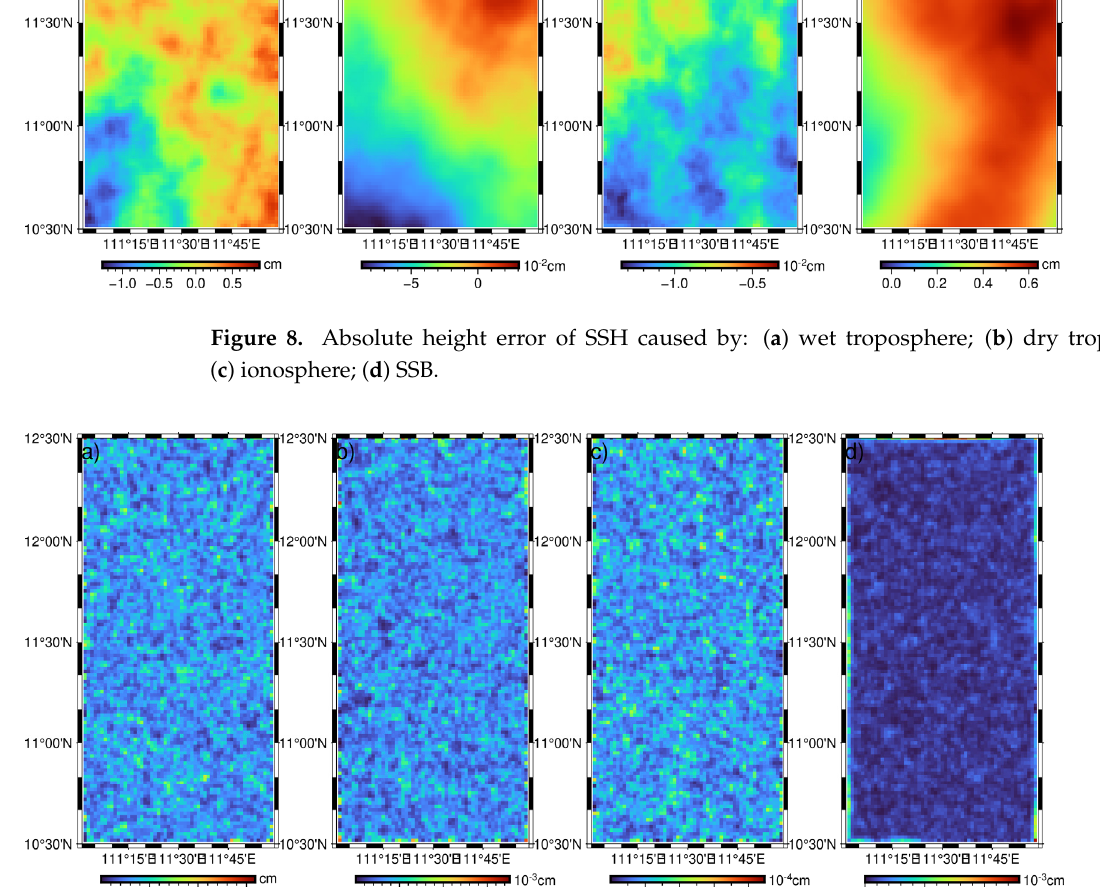
Figure 9. Relative height errors caused by: ( a ) wet troposphere; ( b ) dry troposphere; ( c ) ionosphere; ( d ) SSB. Table 2. Statistics of the errors caused by residual environmental errors ( unit:cm ) .